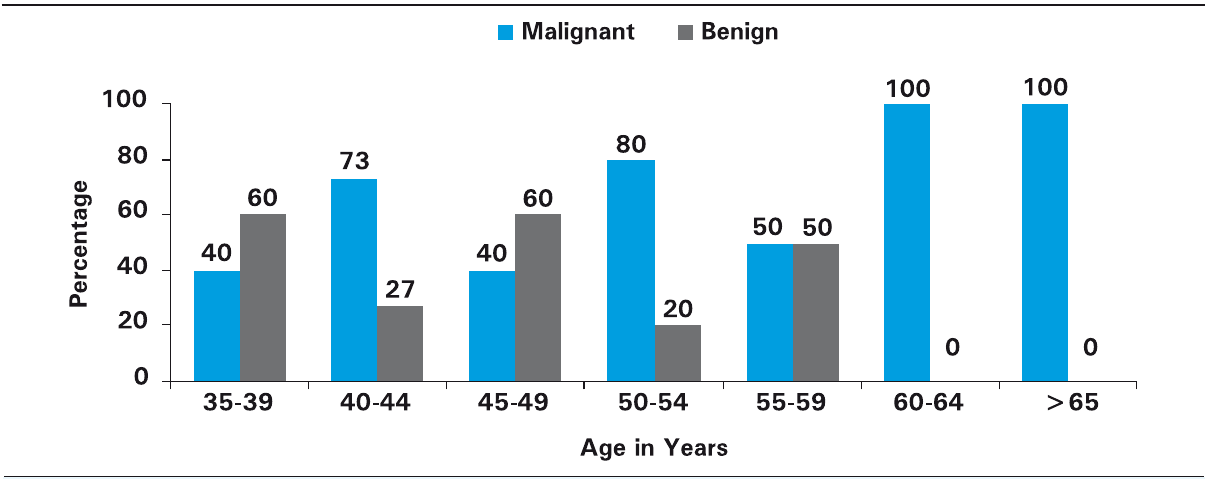
Figure 1. Frequency of malignant and benign diseases in different age